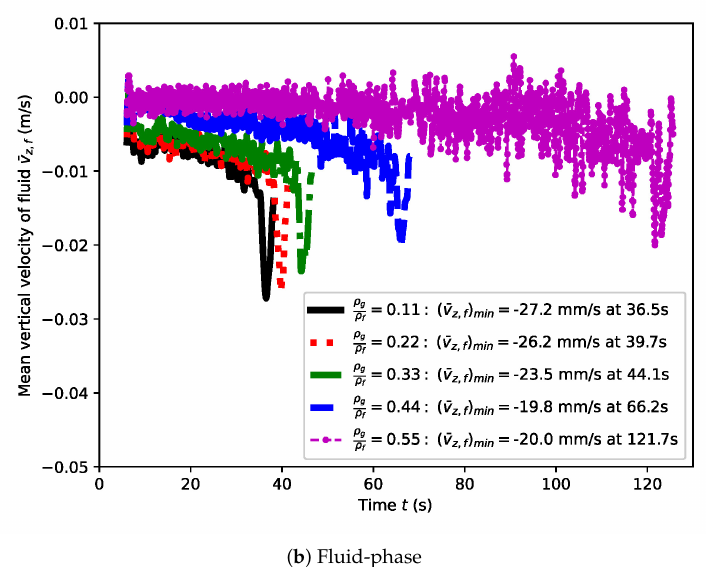
Figure 7. The mean vertical velocities ¯ V z of the bubble ( a ) and the surrounding fluid ( b ) for different = 0.11 − density ratios ρ g ρ f